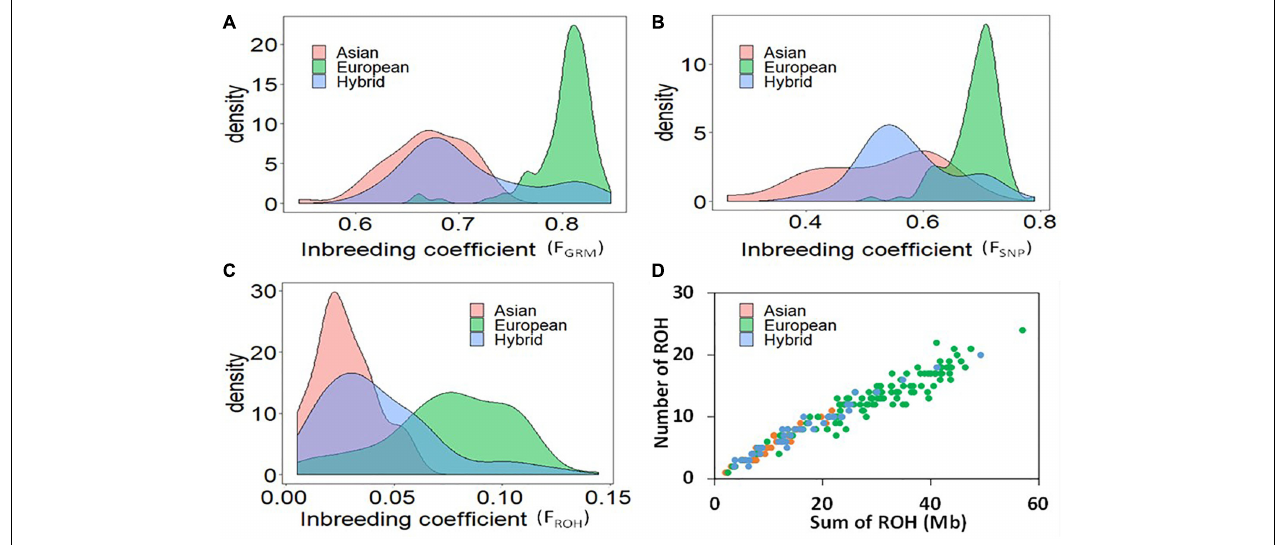
FIGURE 2 | Distribution of the measures of genomic inbreeding coefficients based on genomic relationship matrix (A) , Method of moments (B) , and runs of homozygosity (C) ; and the relationship between the total genomic length covered by ROH and the total number of ROH per individual (D) in Asian, European and hybrid pear population.